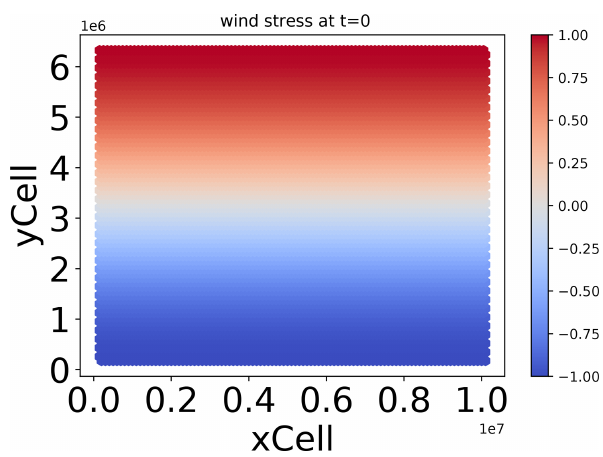
Figure B1. Plot of the initial wind stress profile for the Stommel basin test